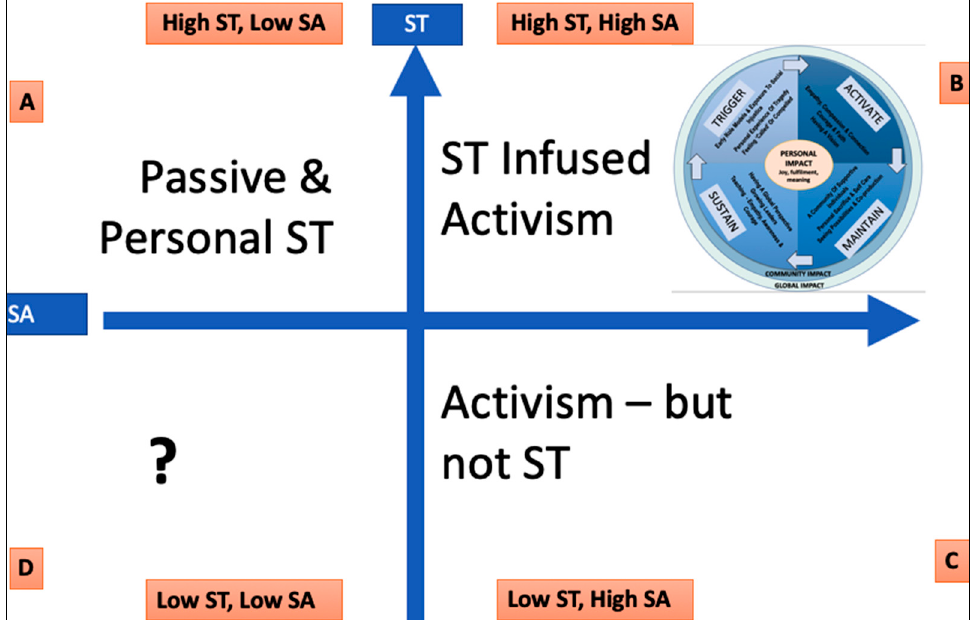
Figure 2. Self-transcendence + social-activism =